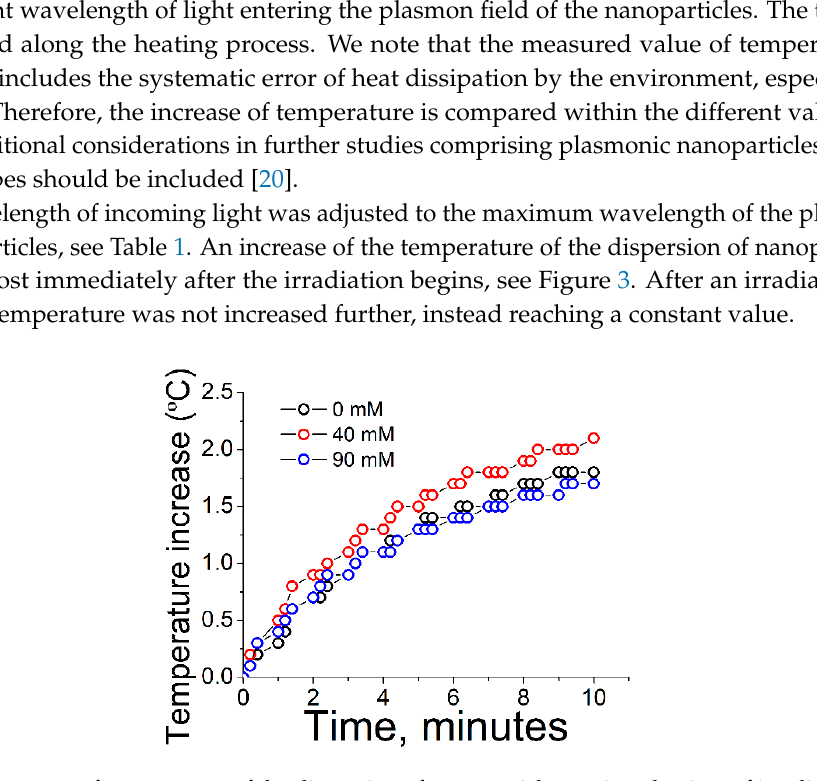
Figure 3. Increase of temperature of the dispersion of nanoparticles against the time of irradiation for different values of sodium chloride concentration: 0 mM (black circles), 40 mM (red circles), and 90 mM (blue circles). The standard deviation between measurements was in all cases equal to or lower than 5%.